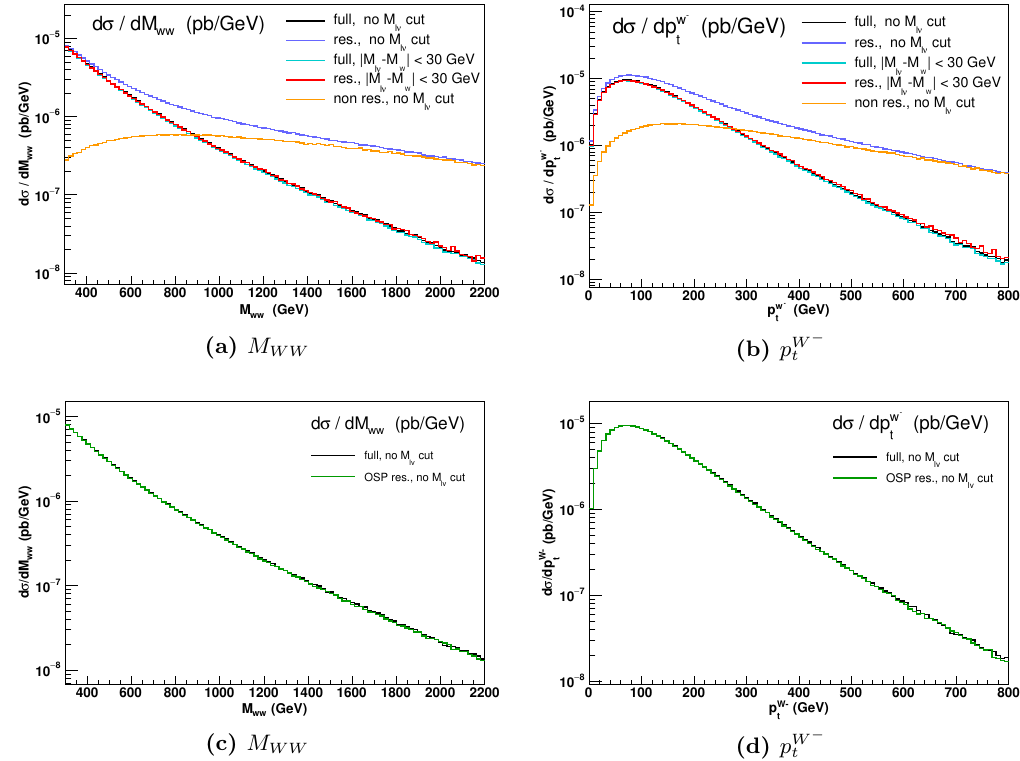
Figure 11. Di(cid:11)erential cross sections as a function of M WW and p W (cid:0)